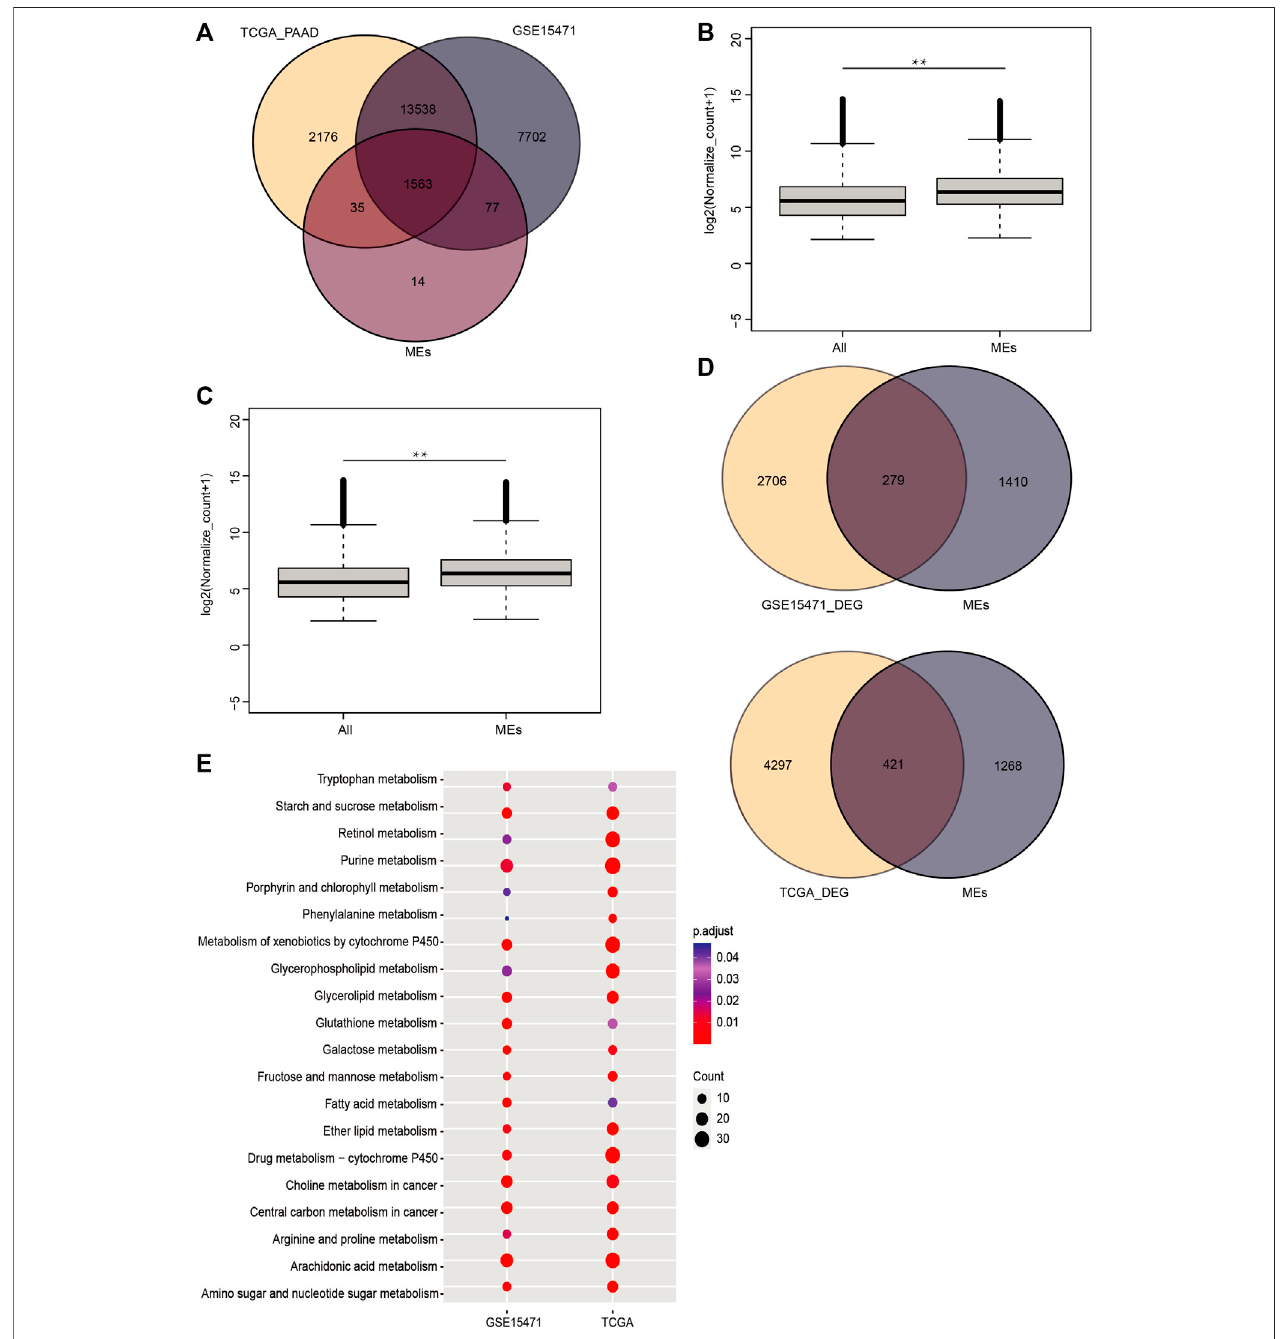
FIGURE 1 | In PC, metabolic enzyme-genes are abnormally expressed. (A) Venn diagram of metabolic enzyme-genes in human pancreatic cancer. (B,C) Comparison of the expression levels of other highly expressed genes and metabolic enzyme genes in the TCGA and GSE15471 data (**, Pvalue < 0.01). (D) Venn diagram of differentially expressed genes and metabolic enzyme genes in the TCGA and GSE15471 data. The KEGG pathway enrichment analysis for the differentially expressed genes. (E) The TCGA and GSE15471 data showed that metabolic pathways, including the glutathione pathway, were enriched in both sets of data ( p <